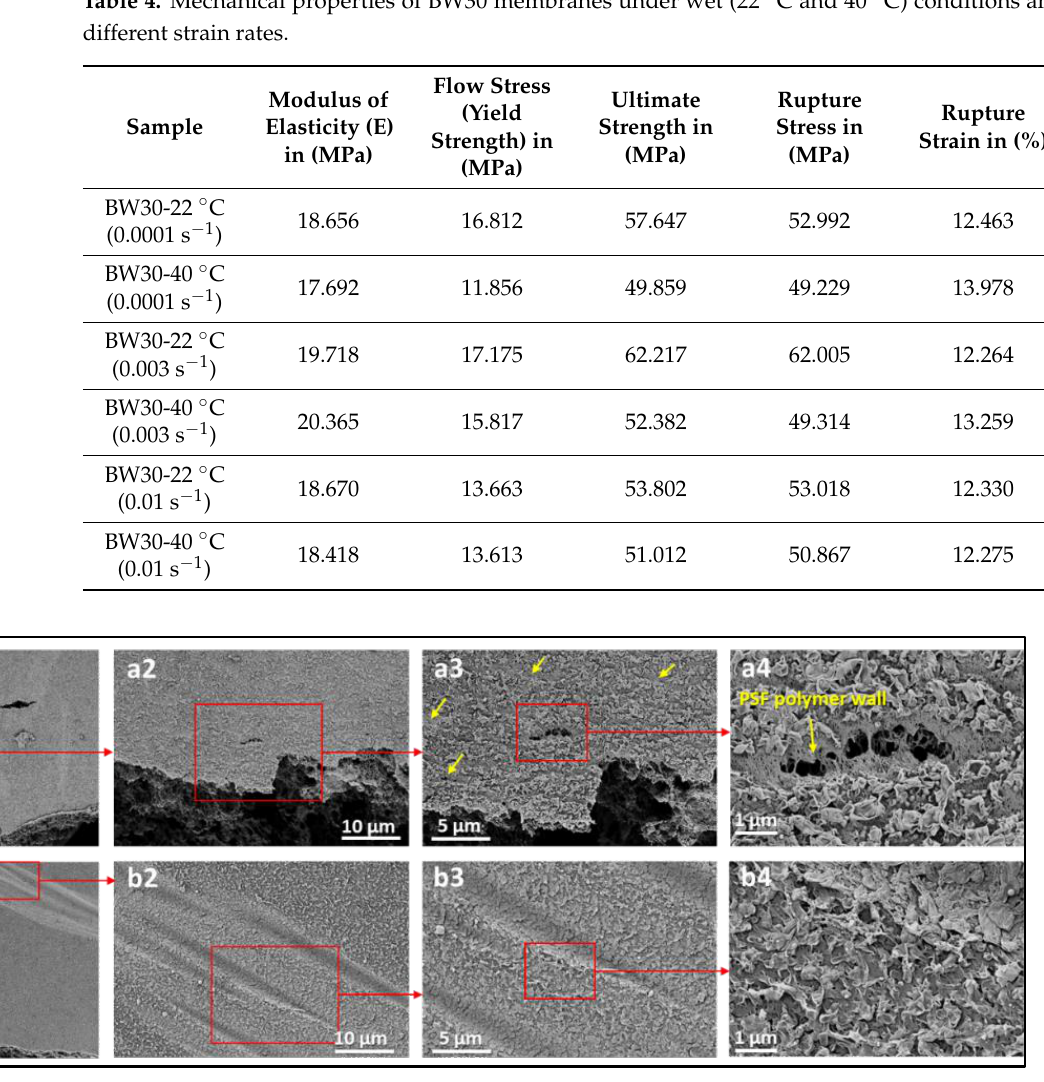
Figure 10. SEM images of the backing-free ( a1 – a3 ) PSF (M2) and ( b1 – b3 ) TFC2-0° membranes tested under dry conditions. The yellow arrows indicate cracks observed in areas close to the fracture re- gion.